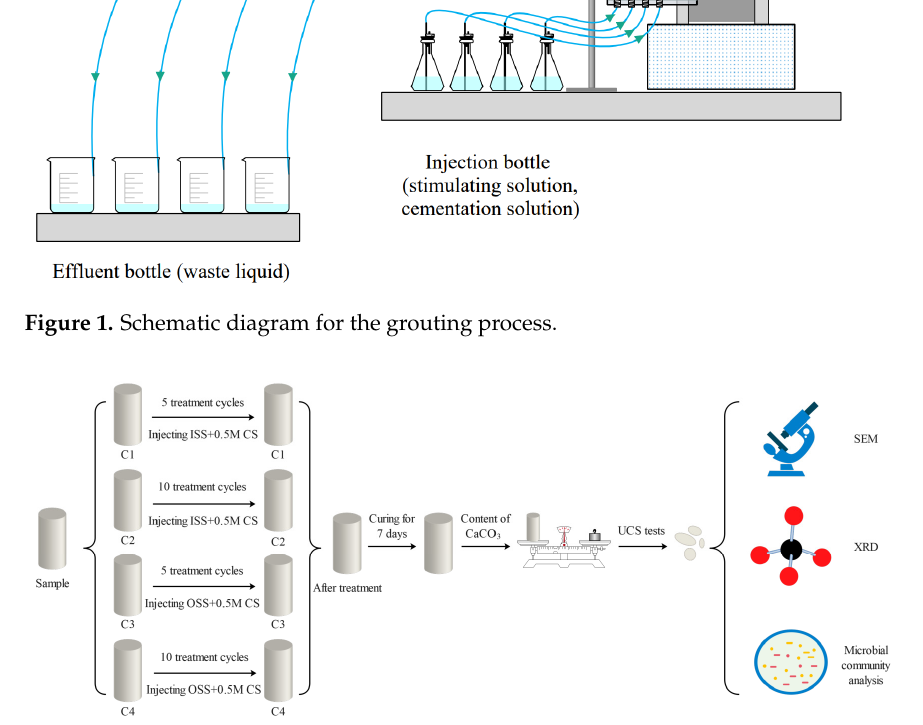
Figure 2. Mineralization scheme and parameter setting (ISS, initial stimulation solution; OSS, opti- mized stimulation solution; CS, cementation solution).